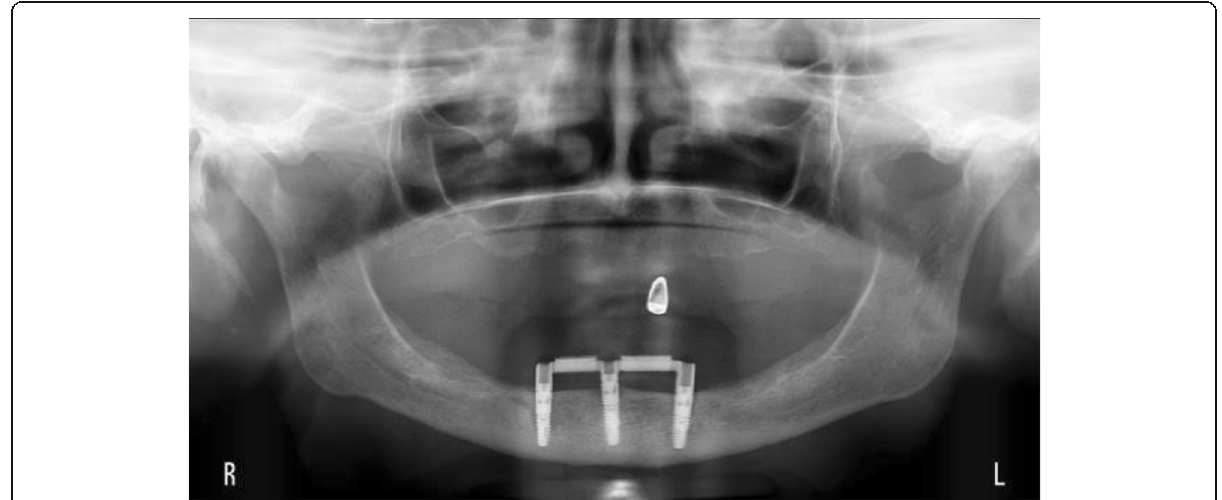
Fig. 3 Rotational panoramic radiograph at the time of the evaluation visit of a patient of the 3-implant group